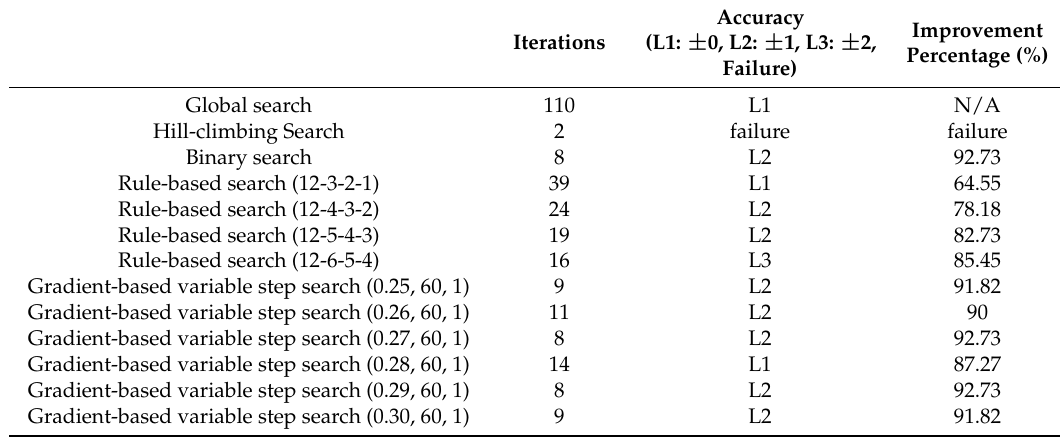
Table 2. Comparison of studied search